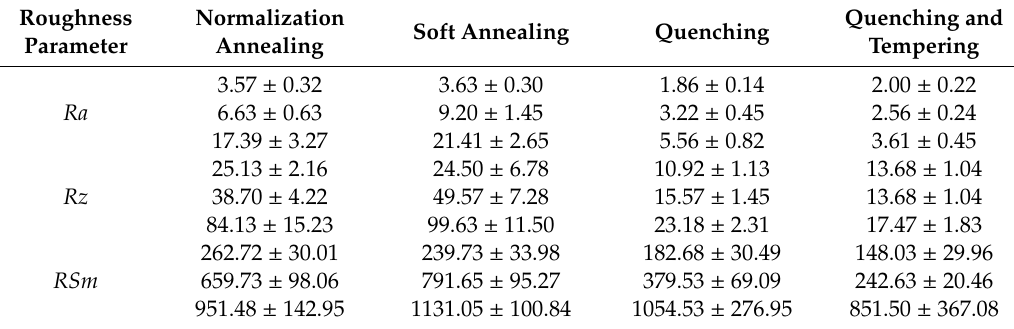
Table 7. Surface roughness characteristics after abrasive waterjet cutting.